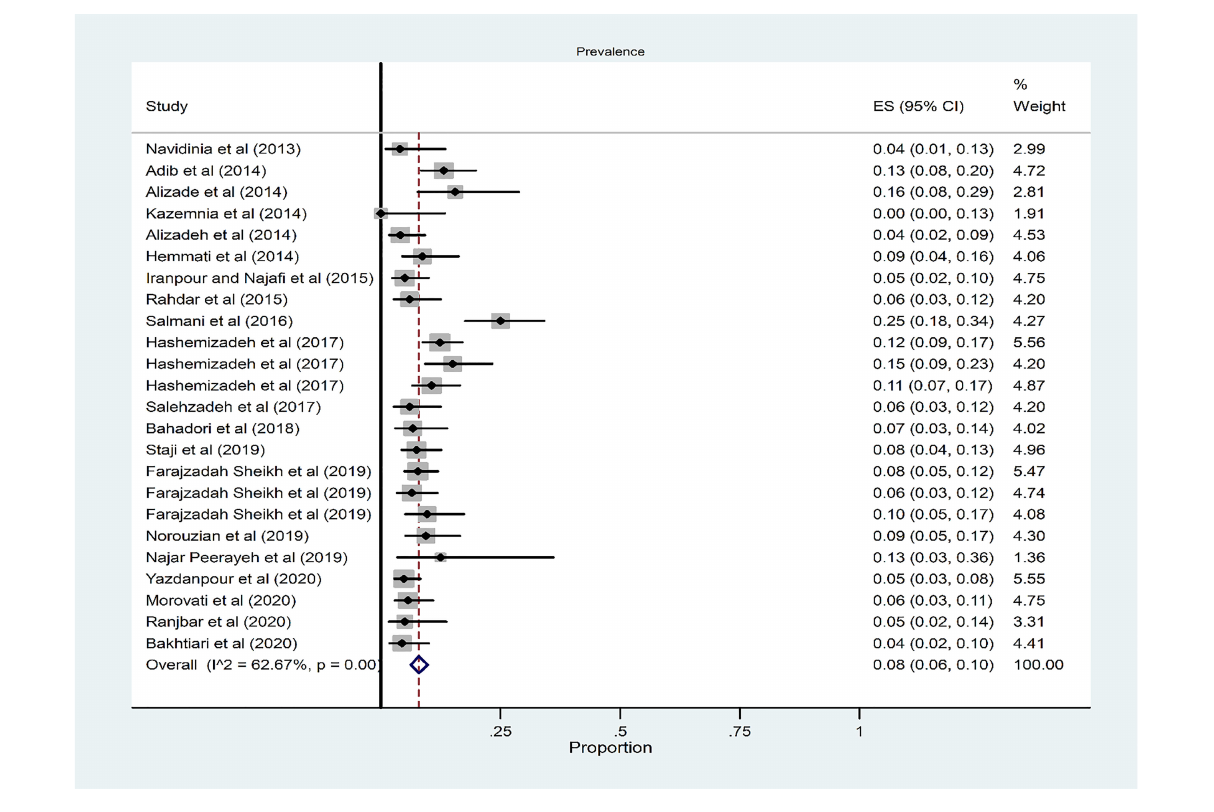
FIGURE 6 | Forest plot of the meta-analysis of phylogroup B 1 prevalence among UPEC